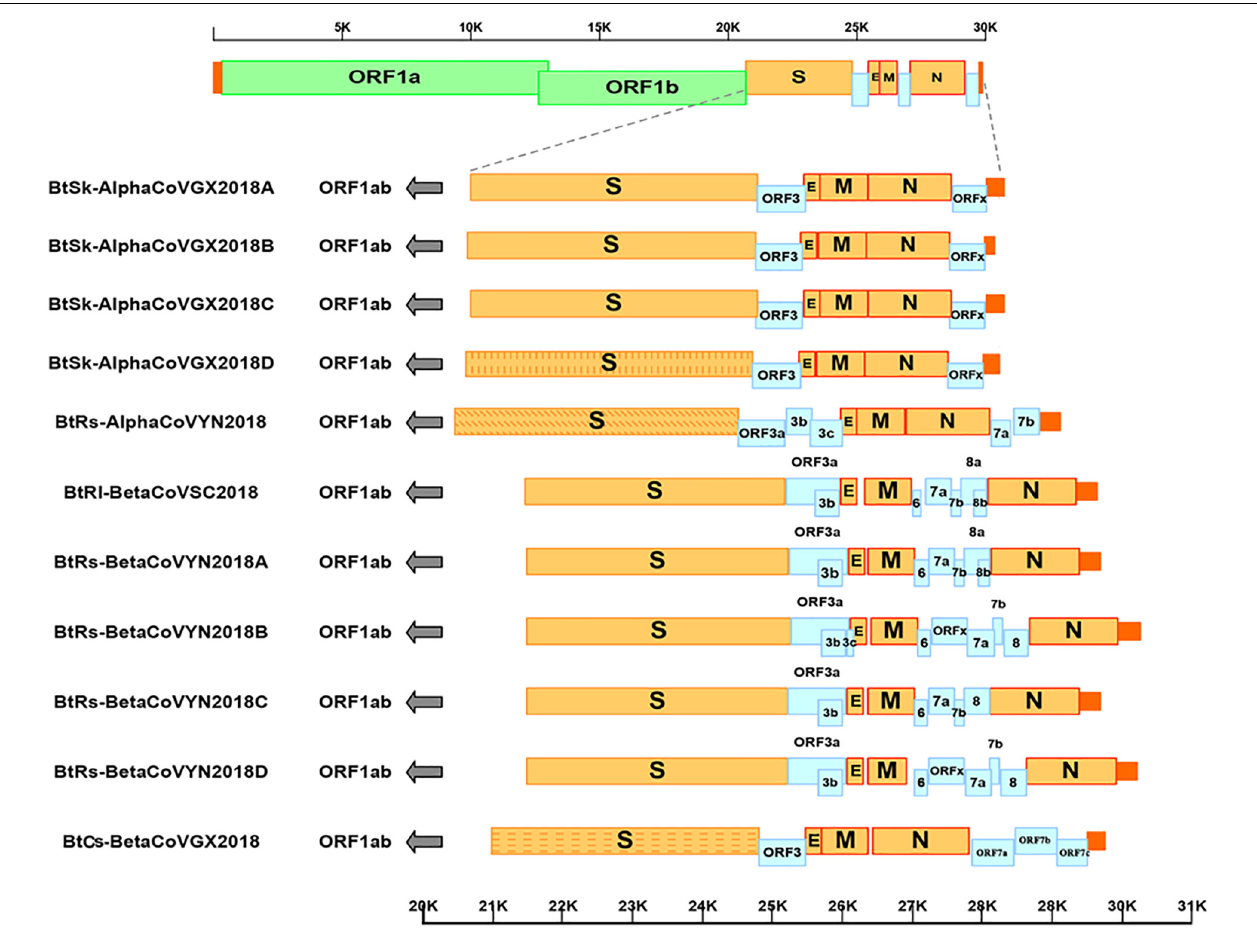
FIGURE 2 | Genome analysis of eleven novel CoVs. Color-coding for different genomic regions as follows. Green, non-structural polyproteins ORF1a and ORF1b; yellow, structural proteins S, E, M and N; blue, accessory proteins ORF3, ORF6, ORFx, ORF7 and ORF8; orange, untranslated